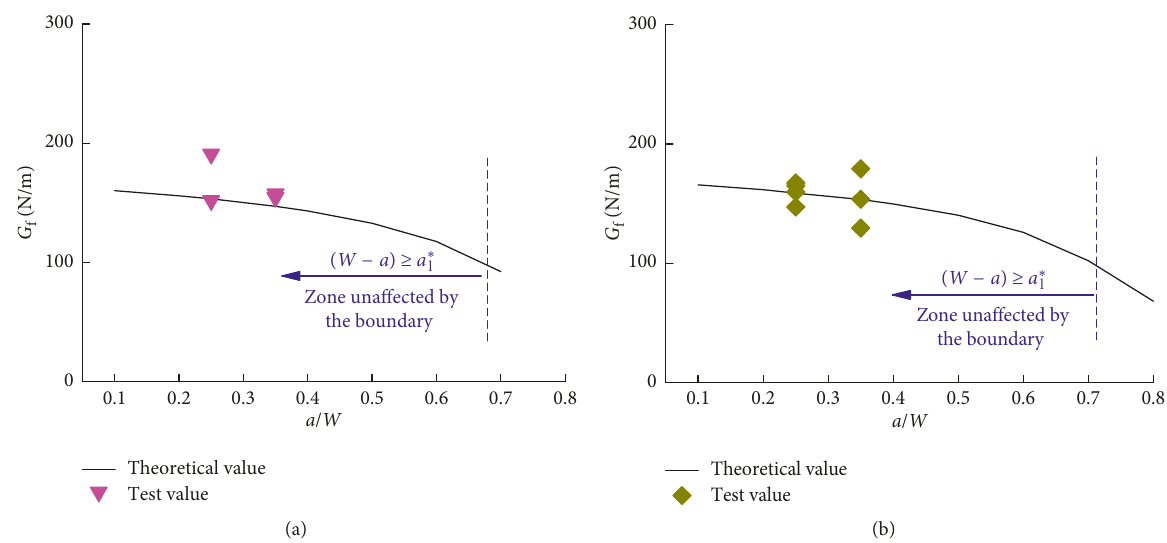
Figure 9: Comparisons of the theoretical with measured fracture energy in the study of Muralidhara et al. [23]. (a) Small size with S / W � 4 and W � 95mm. (b) Large size with S / W � 4 and W �